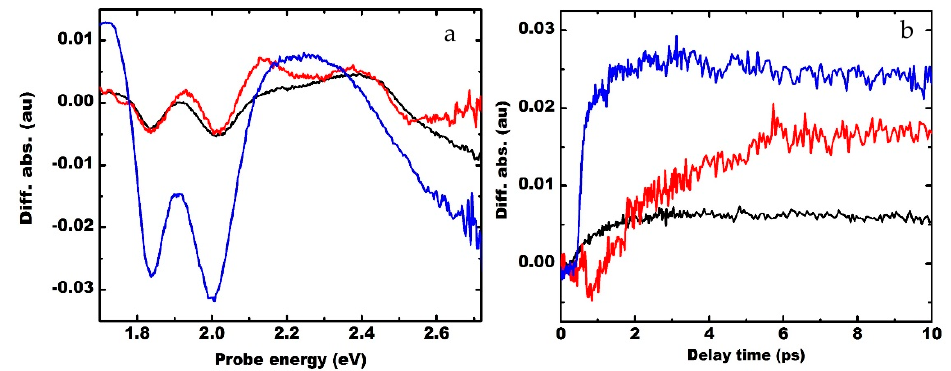
Figure 4. ( a ) Ultrafast absorption spectrum of MoS 2 on quartz with 3.54 eV pump, (black), MoS 2 on GaN with 3.54 eV pump, (red) and MoS 2 on GaN with 3.06 eV pump, (blue) showing the excitonic absorption state and photoinduced absorption bands at 1 ps with 10 microjoule excitation energy density. ( b ) Decay kinetics showing the recovery of probe absorption for MoS 2 on GaN (black), MoS 2 on GaN with Au plasmons (red), and MoS 2 on GaN with Pt plasmons (blue) at the defect band of GaN (2.26 eV).